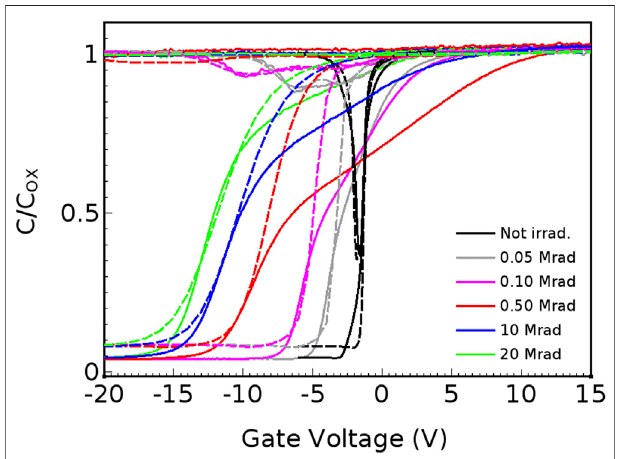
FIGURE 12 | I-V characteristics of p-on-n FBK GD irradiated with X-ray doses of 0.05, 0.50, 1, 10, 20 Mrad(SiO 2 ): comparison between measurements (solid lines) and simulations (dashed lines).